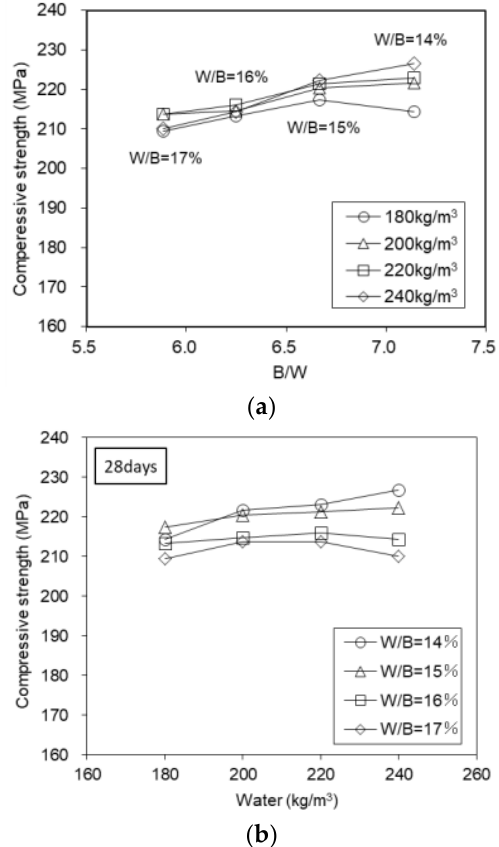
Figure 13. Compressive strength of mortar (cement C). ( a ) B/W — compressive strength. ( b ) Water — compressive strength.